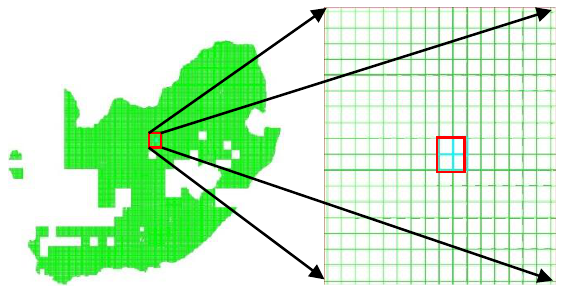
Fig.8.1 MD with image Fig.8.2 Footprints of the small footprints. window in Fig.8.1.